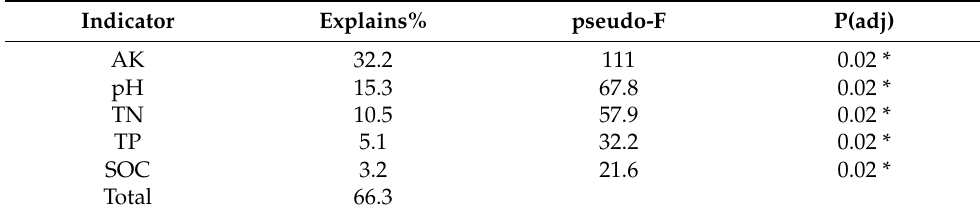
Table 5. The redundancy analysis between rice yield and soil